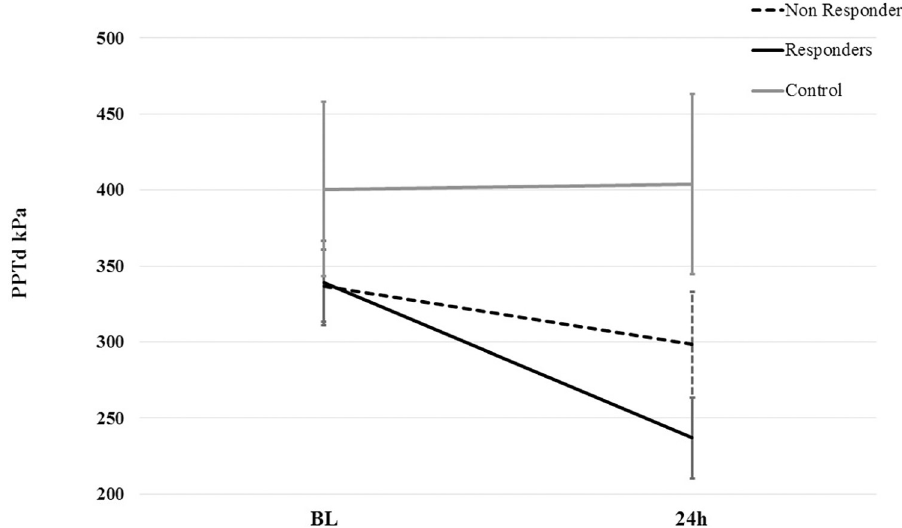
Fig 2. The tree regression analysis to predict DOMS intensity. A regression tree analysis was set up to predict DOMS pain intensity by anxiety score below or above 46 and sex. The numbers in the circles indicate the level of statistical significance (P); and the numbers in the rectangular boxes reflect the total number of cases for that outcome (n) and the mean of pain intensity (y).